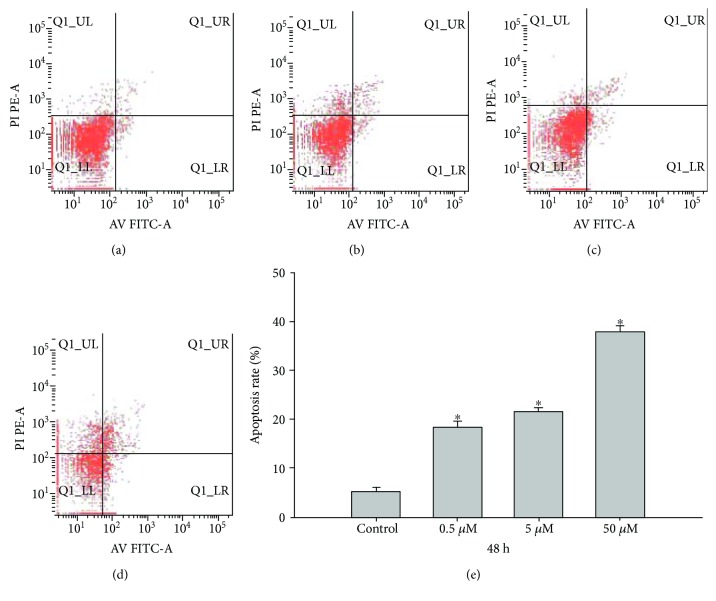
The rate of apoptosis and 5-Aza-CdR concentration show a dose-dependent relationship (∗P < 0.01). (a) Control. (b) 0.5 μmol/L dose group. (c) 5 μmol/L dose group. (d) 50 μmol/L dose group. (e) The statistics of apoptosis rate in each group.